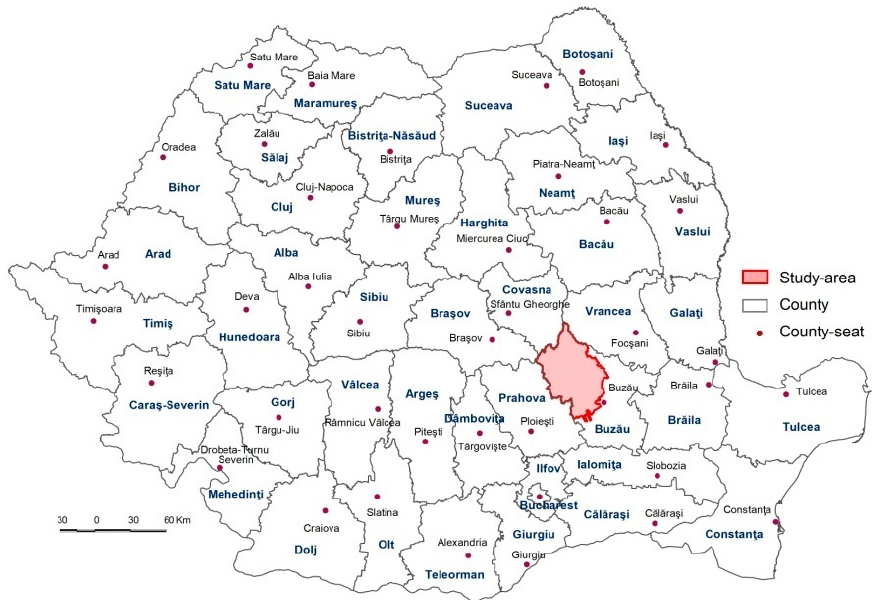
Figure 1. The location of the study area in Romania. The study area, a predominantly rural region, is facing complex socio-economic and environmental issues. After multiple socio-economic transformations, as a result of the en- forcement of communist policy guidelines and of the post-communist (post-1990) economic, social and political transitions, the study area has faced numerous problems similar to the rest of rural and urban areas in Romania. The latter are reflected in the imbalance between the environmental components, the underdevelopment of the rural economy, and last but not least in the low life quality of the rural communities. In terms of demographic size, the communes are grouped into two main categories: under 5000 inhabitants (28 communes) and between 5000 and 10,000 inhabitants (4 communes). The two towns, Nehoiu and P ă t â rlagele, are small sized, with a population of 10,492 inh. and 7319 inh., respectively (Figure